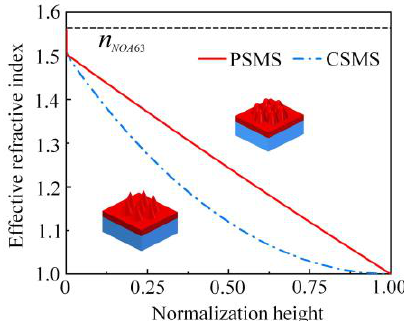
Figure 3. The effective refractive index change between air and the NOA63 film at normal incident. Normalized height 1 represents the peak of the moth-eye structure, and 0 represents the base of the surface of the NOA63 film.